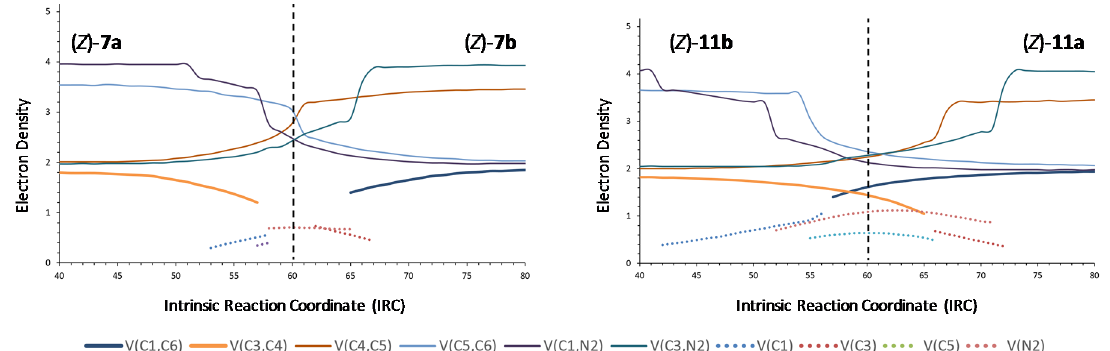
Figure 7. ELF analyses for the 2-aza-Cope rearrangement of nitrones ( Z )- 7 and ( Z )- 11 .